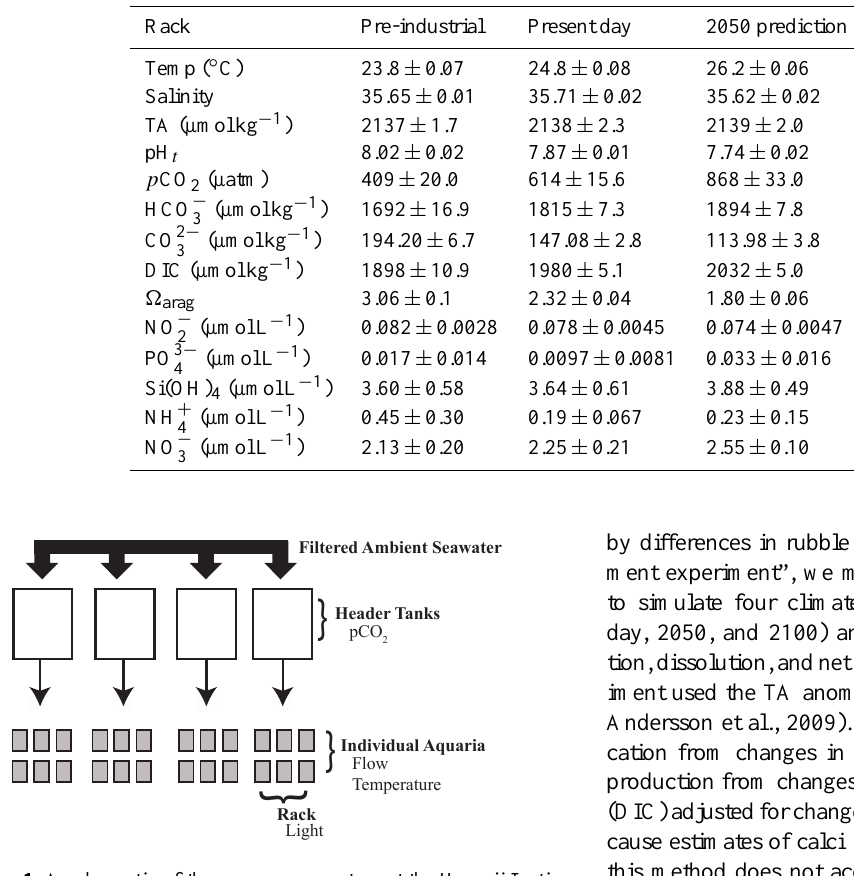
Table 1. Means and standard errors of all measured parameters by rack. p CO 2 , HCO − the measured TA and pH samples using CO 2 SYS. Each table entry is the mean of 12 water samples: one daytime sample and one nighttime sample for six aquaria within a rack. Data are all from the imposed treatment conditions with no rubble inside the aquaria.